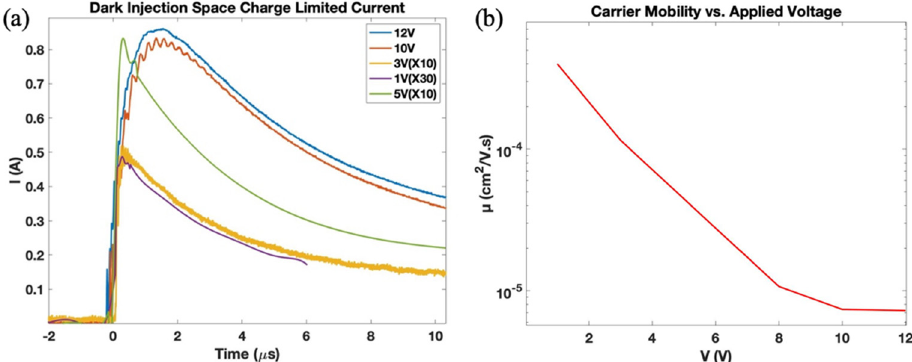
Figure 5. Charge mobility characterization: ( a ) SCLC current transient, ( b ) measured charge mobility vs. applied voltage.